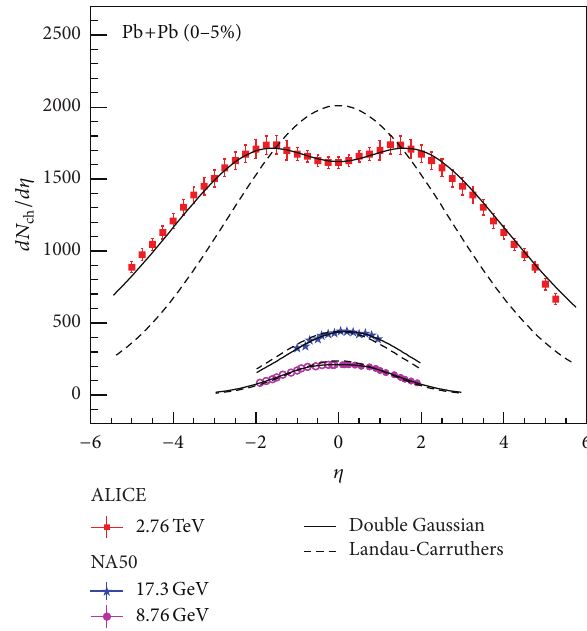
Figure 15: The charged particle multiplicity density distributions of Au+Au collisions at three different energies, fitted with double Gaussian function and Landau-Carruthers functions.